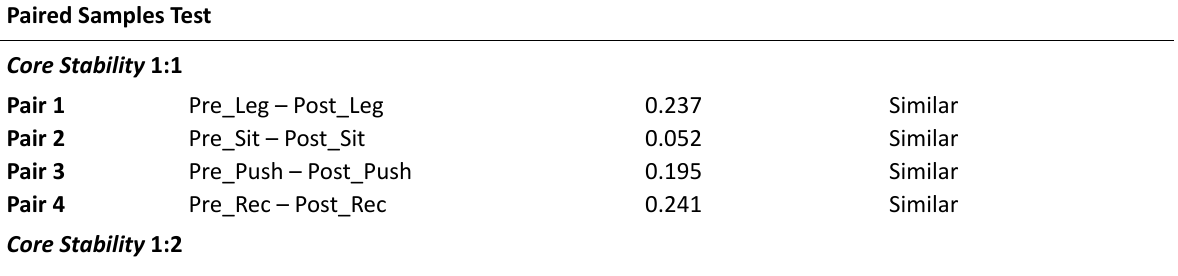
Table 3. The Counting Result of Paired Sample T-Test Paired Samples Test